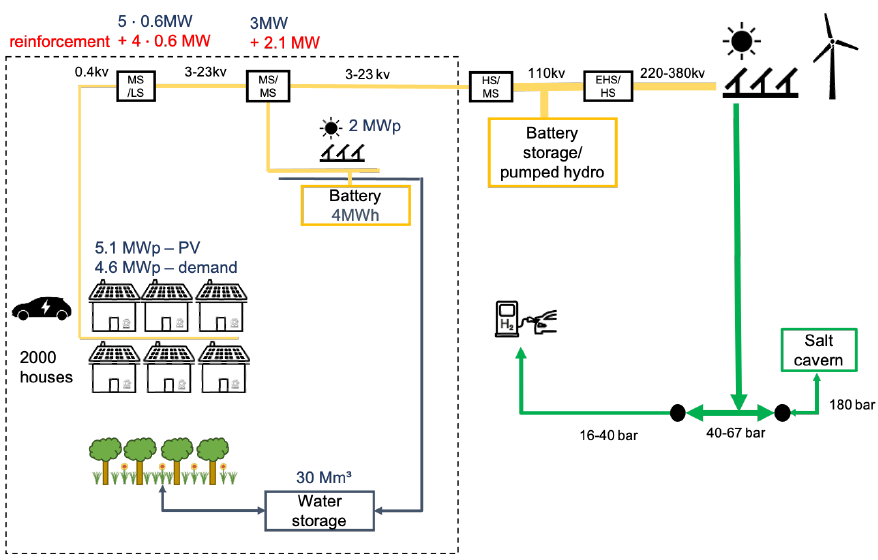
Figure 3. Schematic overview of the all-electric scenario with the respective supply and storage capacities. This scenario is based on 100% renewable electricity, either from local PV production on roofs or the local solar park or imported from large-scale renewable capacity via the electricity grid. The system boundary is shown with a dotted line. Outside of the system boundary, we do not model the electricity production, conversion and storage. However, we assume both electricity storage (in the form of batteries or pumped hydro) and hydrogen storage (via electrolysis) in salt caverns are included in the larger energy system. Because of the local PV production and electricity demands for, i.e., heat pumps, the original grid capacity of 3 MW is not sufficient anymore for this neighborhood. The red numbers with the plus sign represent the grid reinforcement that is necessary for this scenario. Inverters are not shown in this picture but are necessary for the transformation of DC to AC electricity.